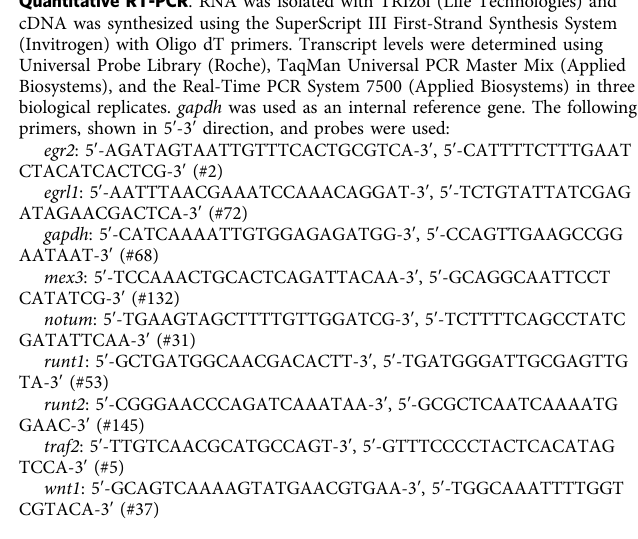
patched: 5 ′ -TGTGCGACAATTTTGATGG-3 ′ , 5 ′ -CATCGGTGCCTTTTGT TTT-3 ′ Quantitative RT-PCR . RNA was isolated with TRIzol (Life Technologies) and cDNA was synthesized using the SuperScript III First-Strand Synthesis System (Invitrogen) with Oligo dT primers. Transcript levels were determined using Universal Probe Library (Roche), TaqMan Universal PCR Master Mix (Applied Biosystems), and the Real-Time PCR System 7500 (Applied Biosystems) in three biological replicates. gapdh was used as an internal reference gene. The following primers, shown in 5 ′ -3 ′ direction, and probes were used: egr2 : 5 ′ -AGATAGTAATTGTTTCACTGCGTCA-3 ′ , 5 ′